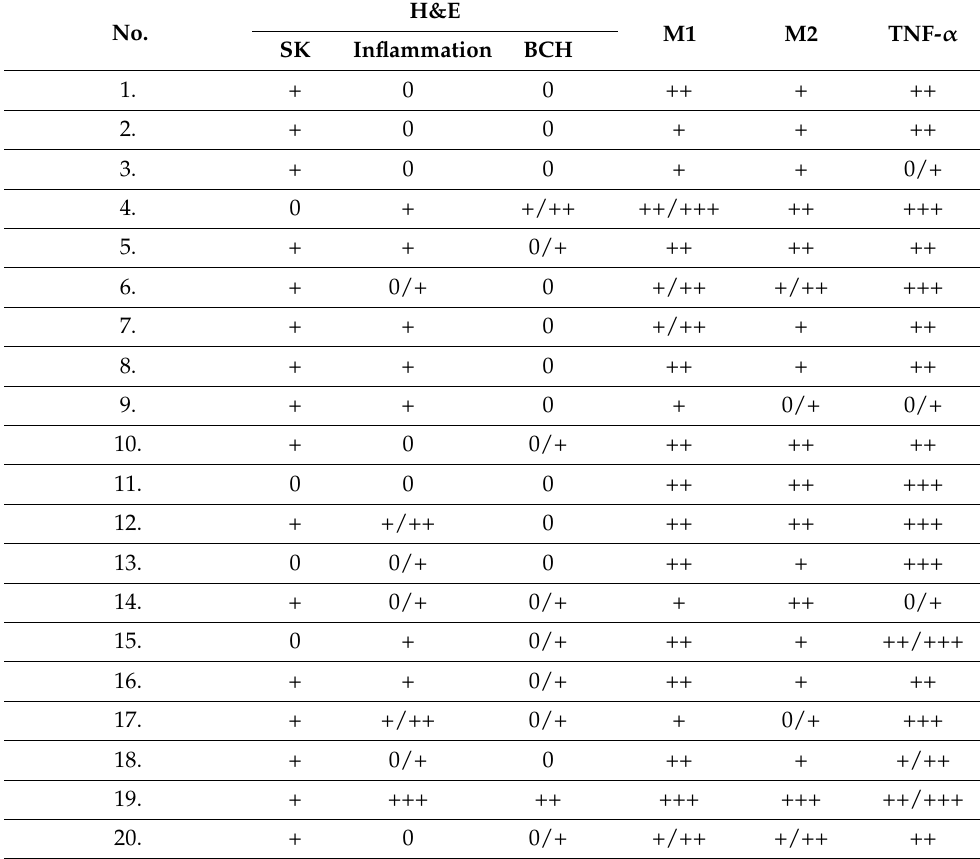
Table 2. The relative number of M1-, M2-, and TNF- α -positive structures and the degree of seborrheic keratosis, inflammation, and basal cell hyperplasia present in the cleft affected tissue samples as well as in the control